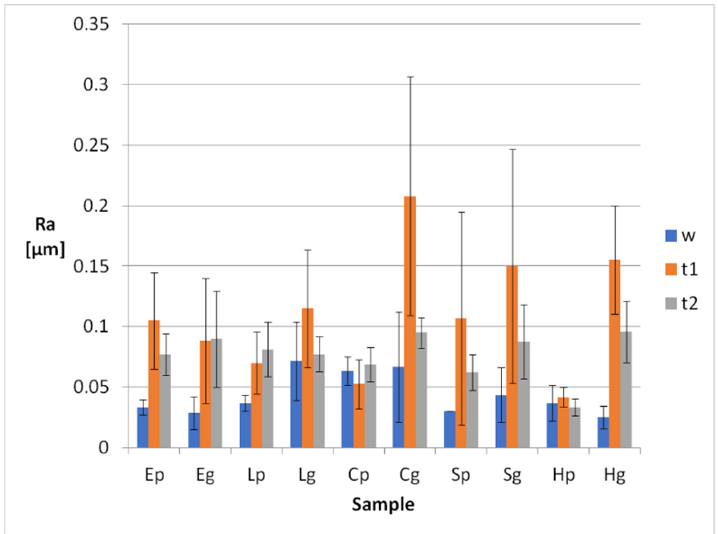
Figure 1. Mean Ra roughness values and SD values of the samples, before and after thermal aging. Related to surface processing, TP and OP values increased and CR decreased for glazed samples, with results being significant before thermocycling and insignificant after. Mean calculated optical parameters ranged between 17.01 and 24.79 for TP, 4.40 and 8.05 for OP, and 0.46 and 0.60 for CR (Figures 2–4, Tables 2–4). TP, OP and CR values were insignificantly changed by